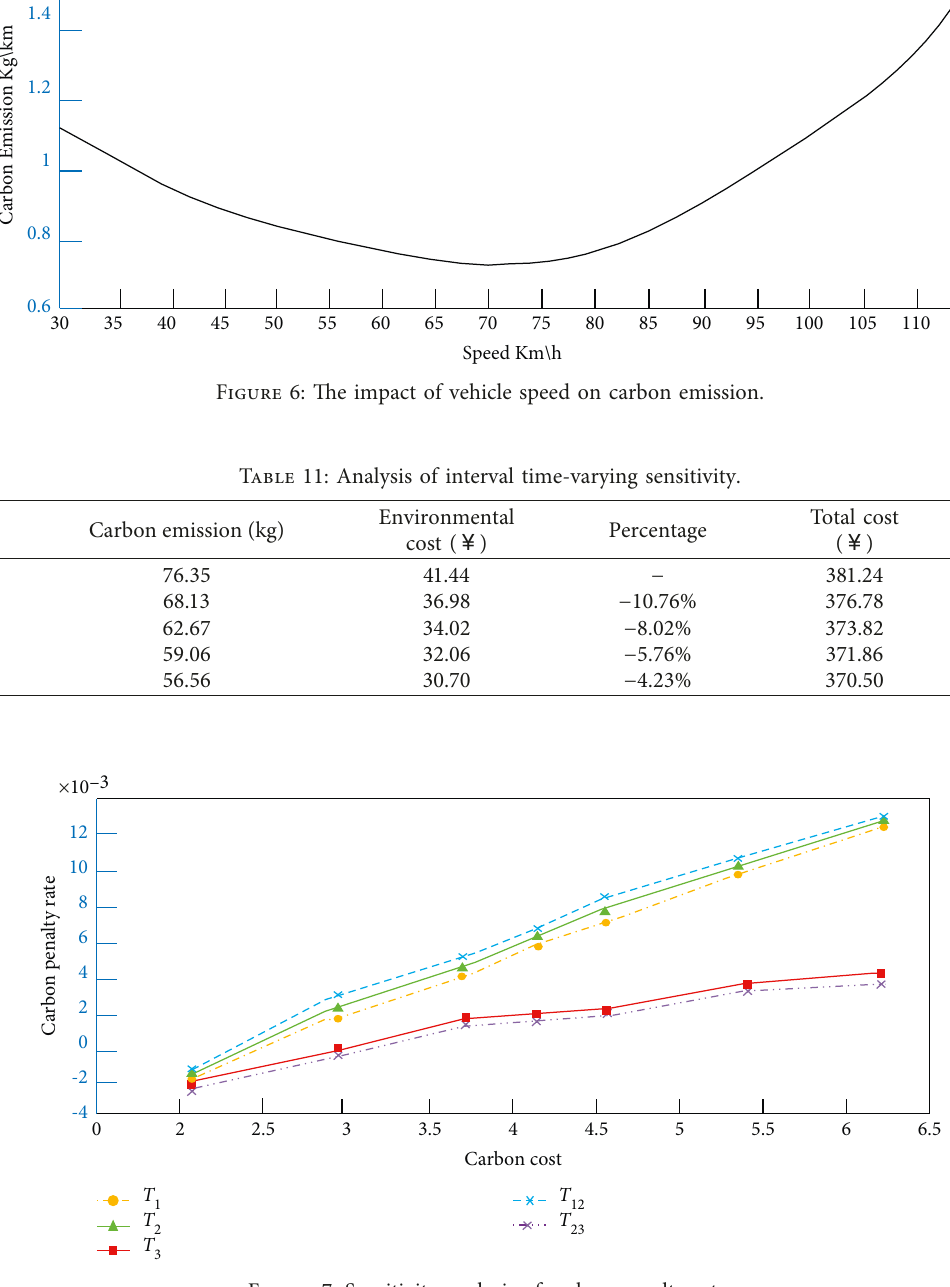
Figure 7: Sensitivity analysis of carbon penalty